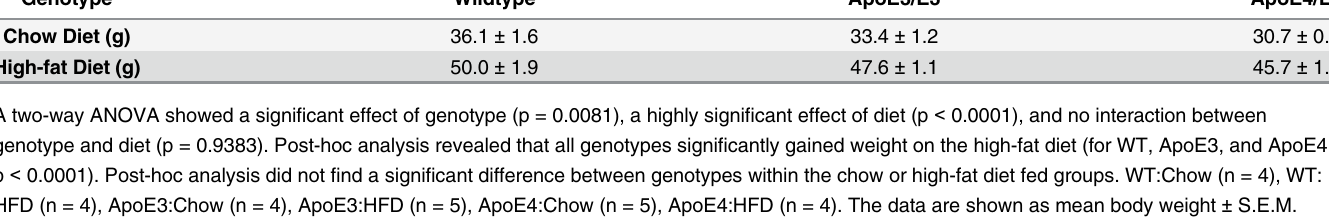
Table 1. High-fat diet (HFD) induces weight gain in wildtype, ApoE3, and ApoE4 mice.